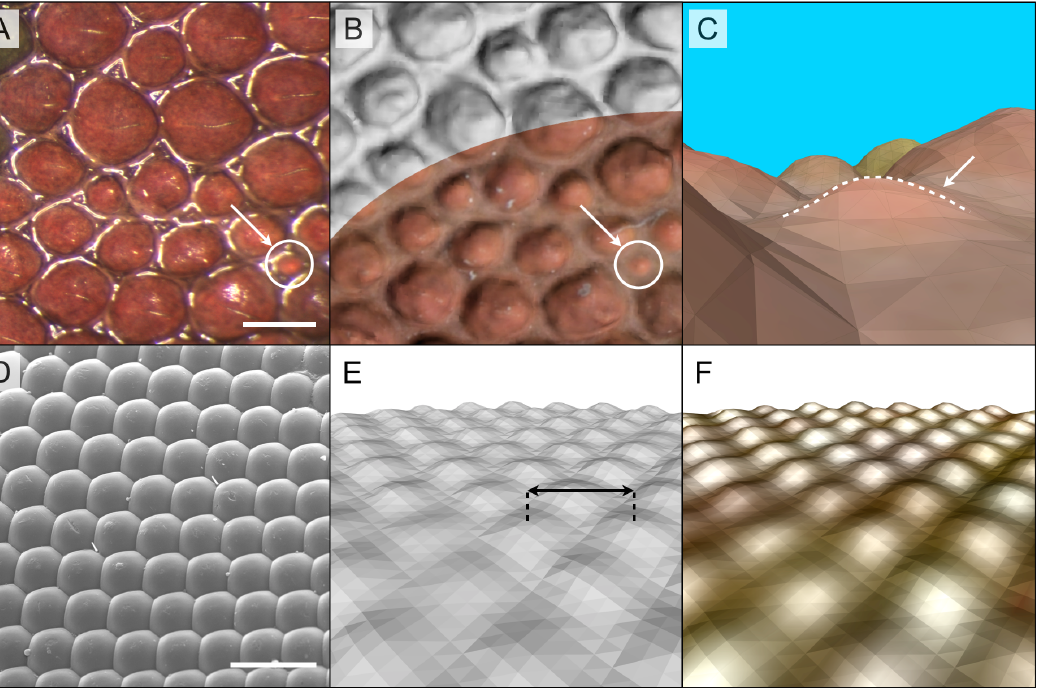
Fig 3. Geometry resolution. A) Picture (taken with a stereoscopic microscope) of a skin patch of a juvenile Phelsuma grandis gecko. Scale bar: 500 μ m. B ) The PMVS reconstruction of the same patch with and without colour texture. C ) Detail of B for the scale indicated with a white arrow. D) SEM image of a fly compound eye; Scale bar: 50 μ m; E) Surface geometry and F) geometry with colour texture of the same ommatidia as in D , reconstructed with Photometric Stereo (double arrows: distance between two ommatidia = 23 μ